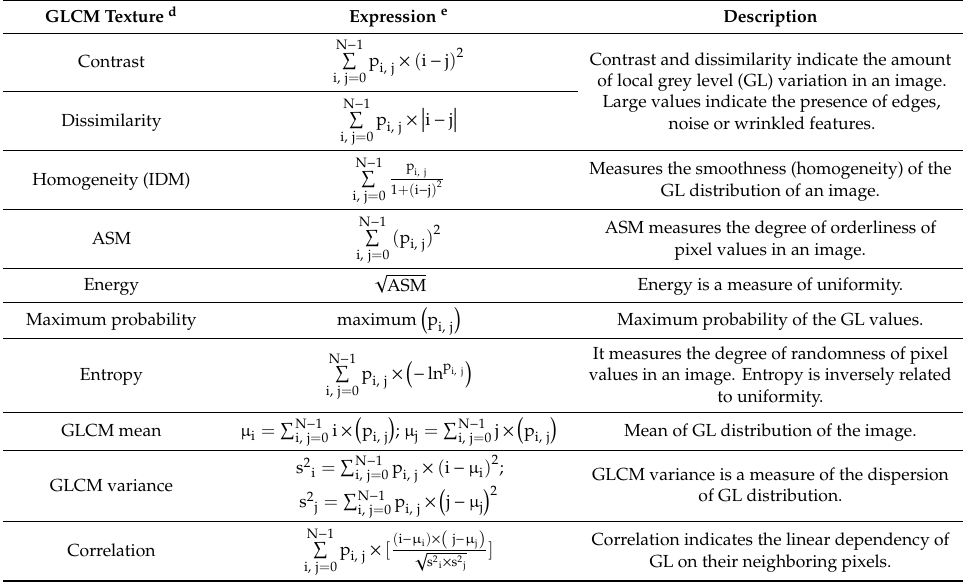
c See Table 1 for description of the acronyms of the SBs used in the expressions of the SIs in this table. Table 3. General description of the grey level co-occurrence matrix (GLCM) texture features used in this study.